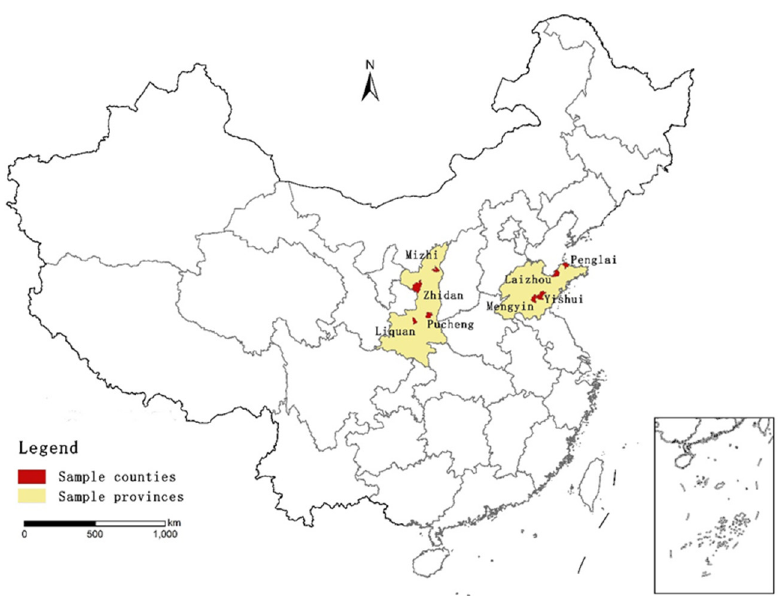
Figure 1. Map of sample provinces and distribution of counties. Source: Authors’ own elaboration through ArcGIS 10.7 software (GeoScene Information Technology Co., Ltd., Beijing, China).